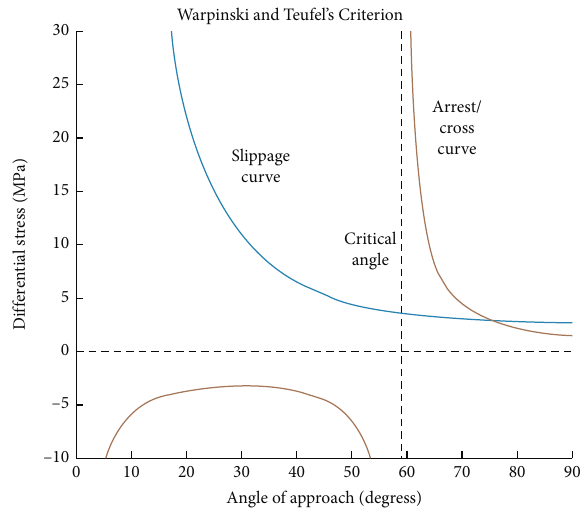
Figure 4: The chart of W&T’s criterion ( p